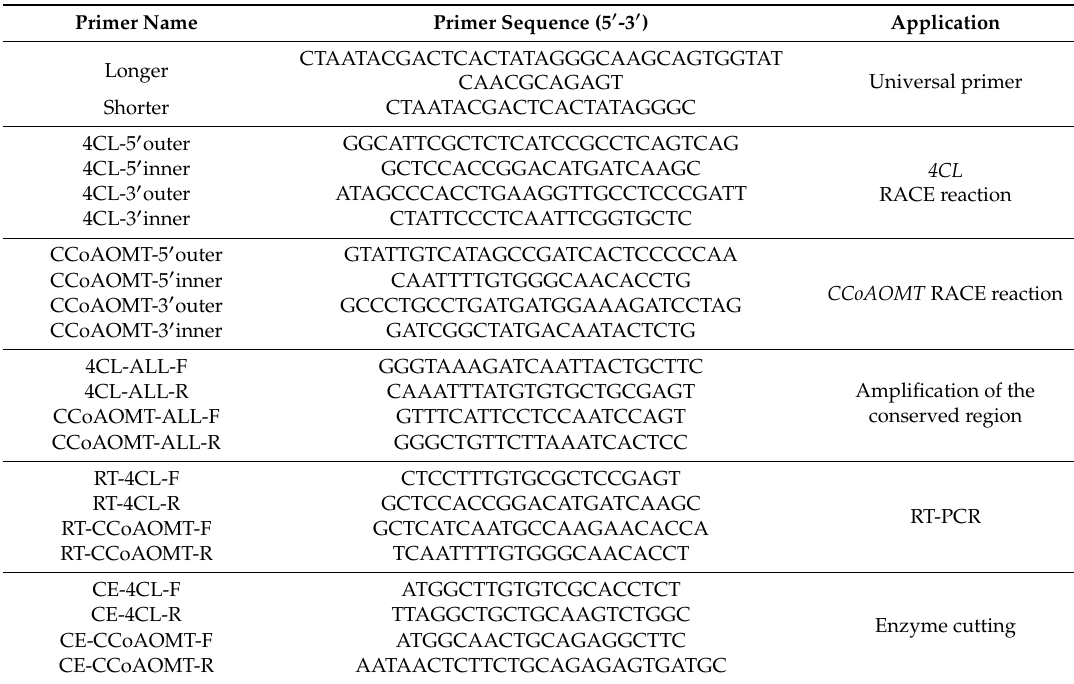
Table 1. Primers used for partial cDNA cloning, RACE reaction,